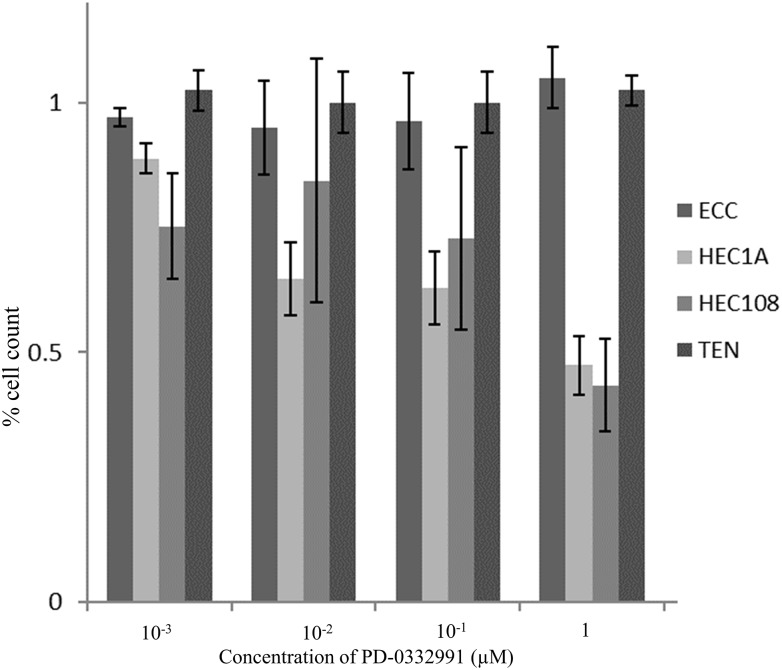
Proliferation ability of endometrial cancer cell lines following treatment with PD-0332991.Cells were plated onto 24-well tissue culture plates at a density of 1 × 104 and grown without or with increasing concentrations of PD-0332991 for 72 hours. In HEC1A and HEC108 cells, PD-0332991 acted as a concentration-dependent inhibitor of cell proliferation with an IC50 of 0.65 and 0.58 μM, respectively. In ECC and TEN cells, however, PD-0332991 did not inhibit cell proliferation, even at concentrations up to 1 μM.